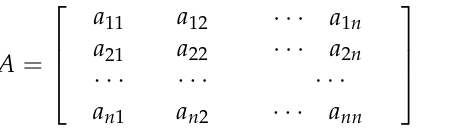
Figure 3. Framework of the evaluation index system for the effective utilization coefficient of irrigation water.